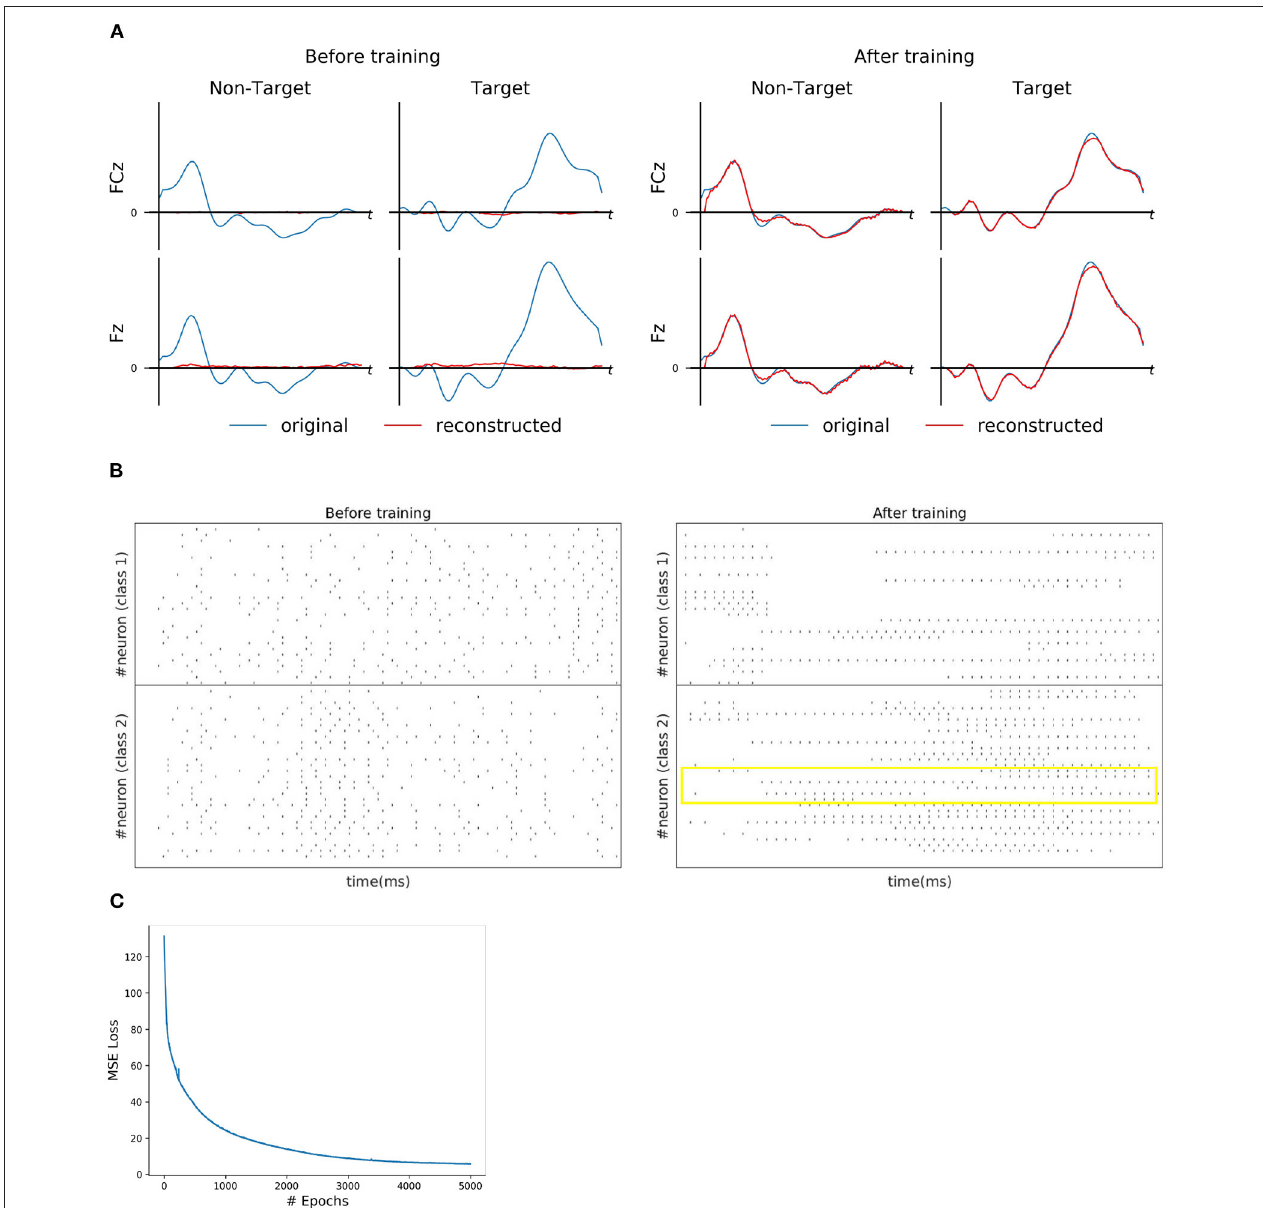
FIGURE 3 | ERN signal reconstruction outcomes. (A) Illustration of original (blue line) and reconstructed (red line) for FCz and Fz EEG signals for both Target and Non-Target classes before and after training. (B) Spike trains of RSNN activity before and after the training process from 30 randomly selected neurons. The yellow box indicates the effectiveness of the training process in reorganizing the spike trains across layers. (C) The convergence of MSE loss value across epochs during the training process. rate) were initialized to acts as input signal to the SNN